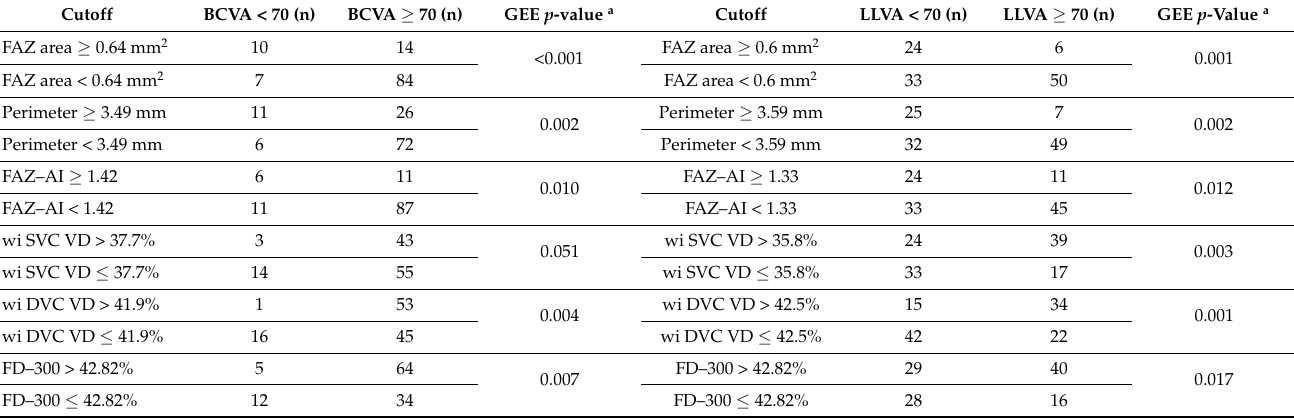
Table 4. The pattern of distribution by applying different cutoff